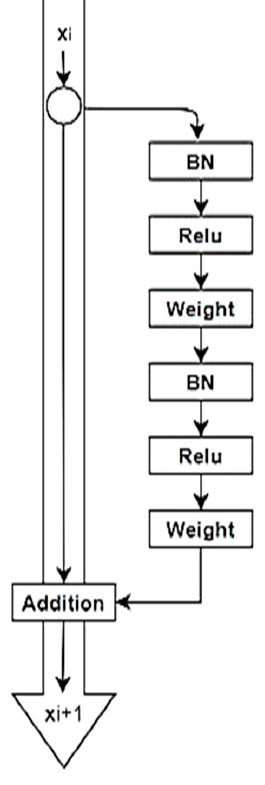
Figure 3. ResNet50v2 architecture.